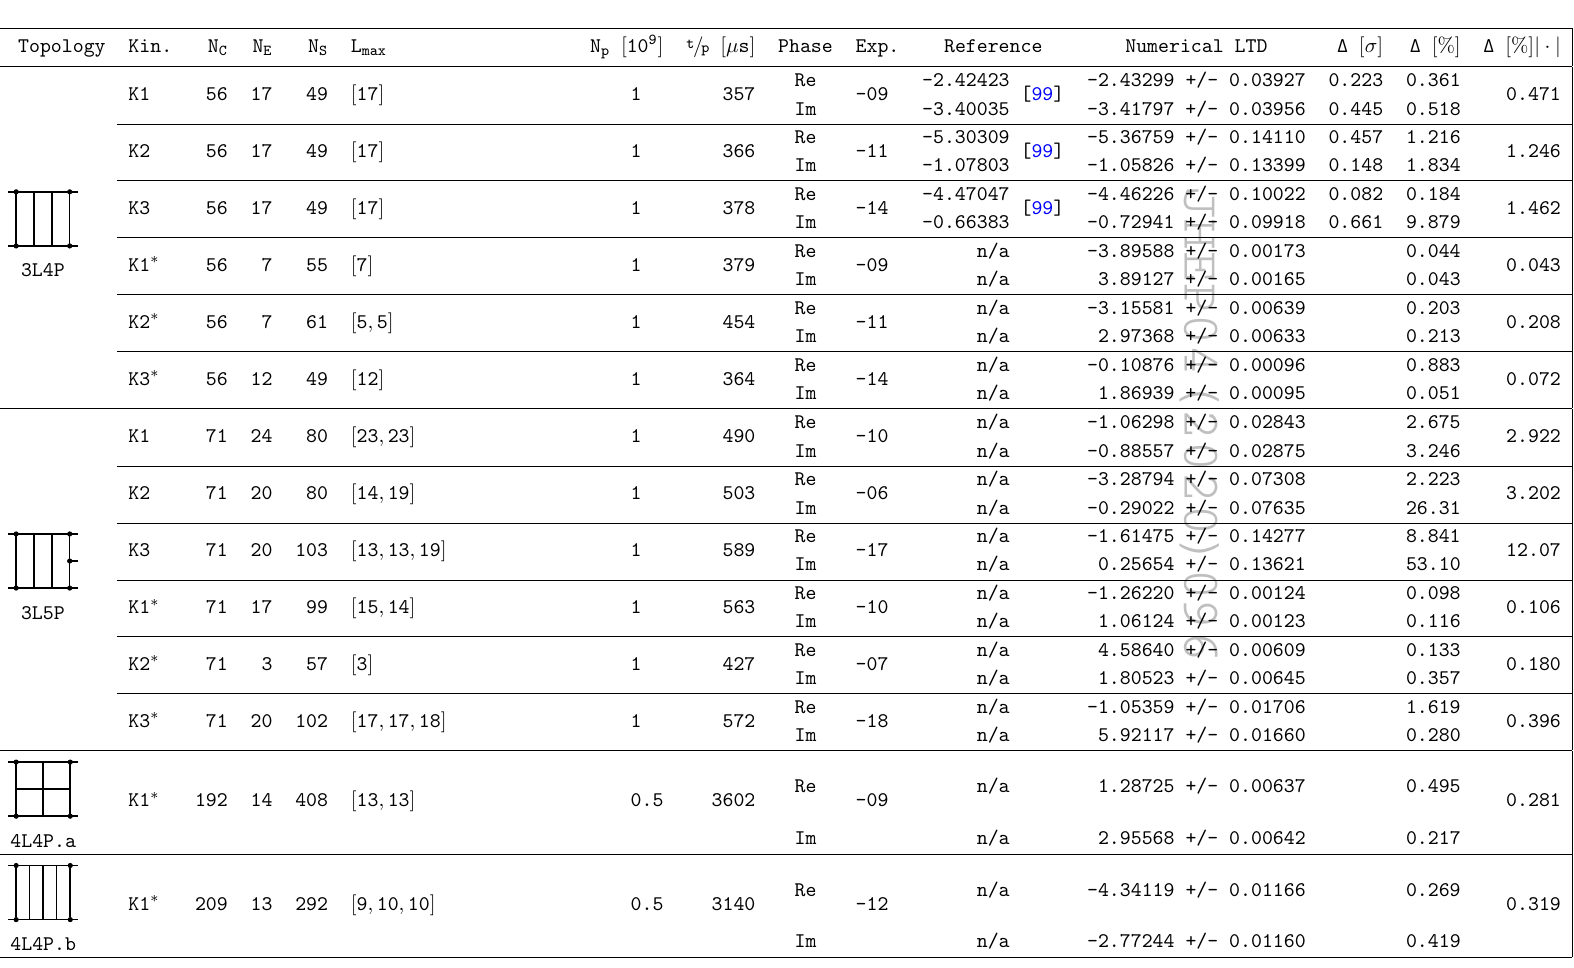
Table 8. Results for three- and four-loop topologies for scattering kinematics (2